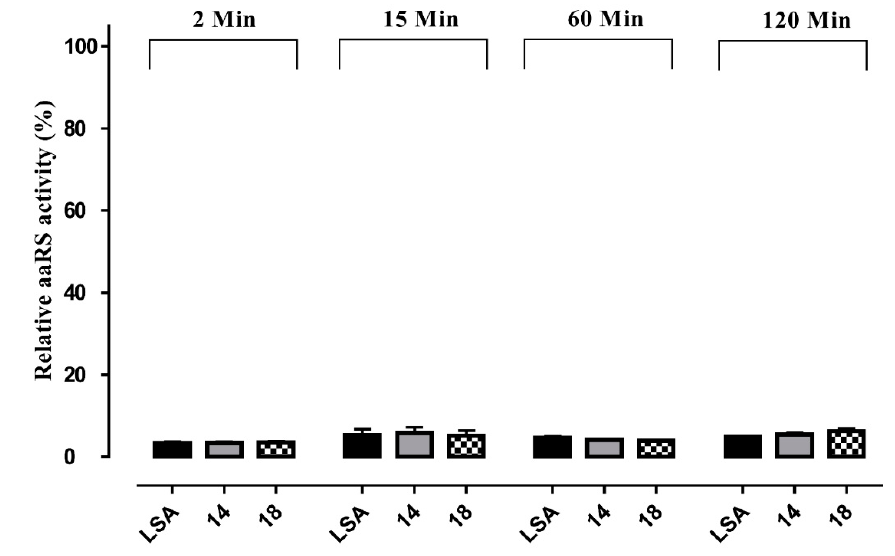
Figure 3. Relative LeuRS activity in the presence of LSA prodrugs in E. coli NCIB 8743 cellular extracts. The activity was determined by measuring the transfer of the appropriate C 14 -labeled amino acid to tRNA in the presence of 250 nM of each compound. The stated prodrugs were incubated at 37 ◦ C in the cell extract for either 2, 15, 60, and 120 min, after which aliquots were taken, and the aminoacylation activity was measured. The relative activity was determined by comparing to the values of the extract measured in the absence of an inhibitor and assuming 100% enzyme activity. The results correspond to an average of three experiments, with SD presented as error bars.